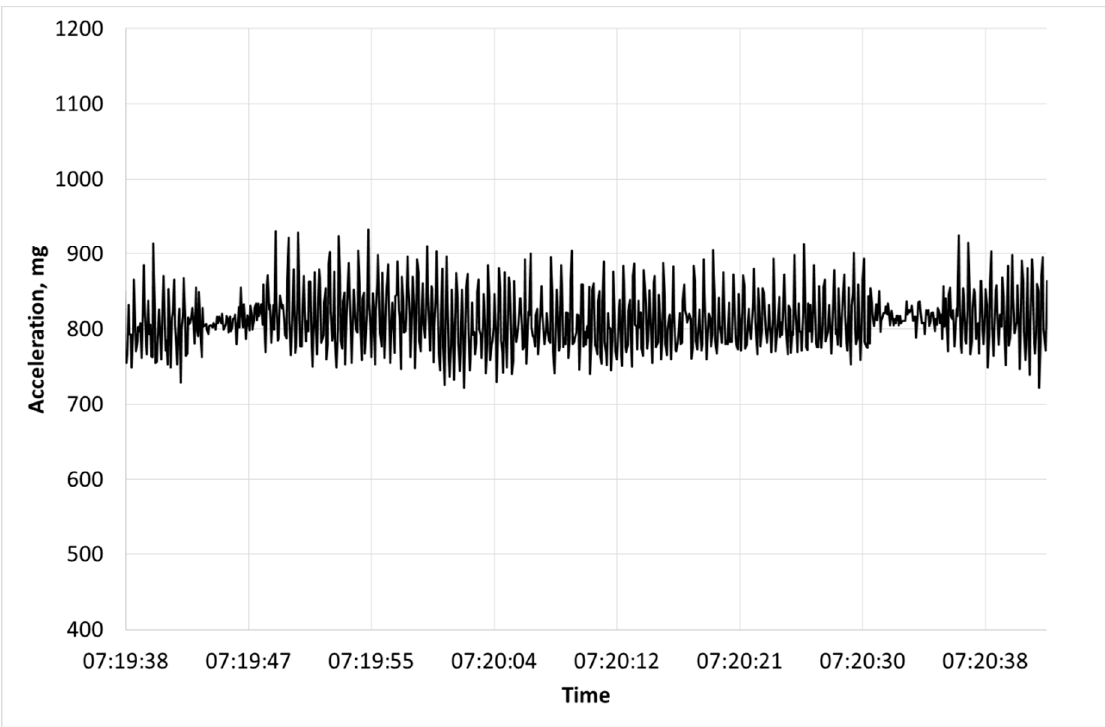
Figure 2. Accelerations from a neck-mounted collar measured during rumination.